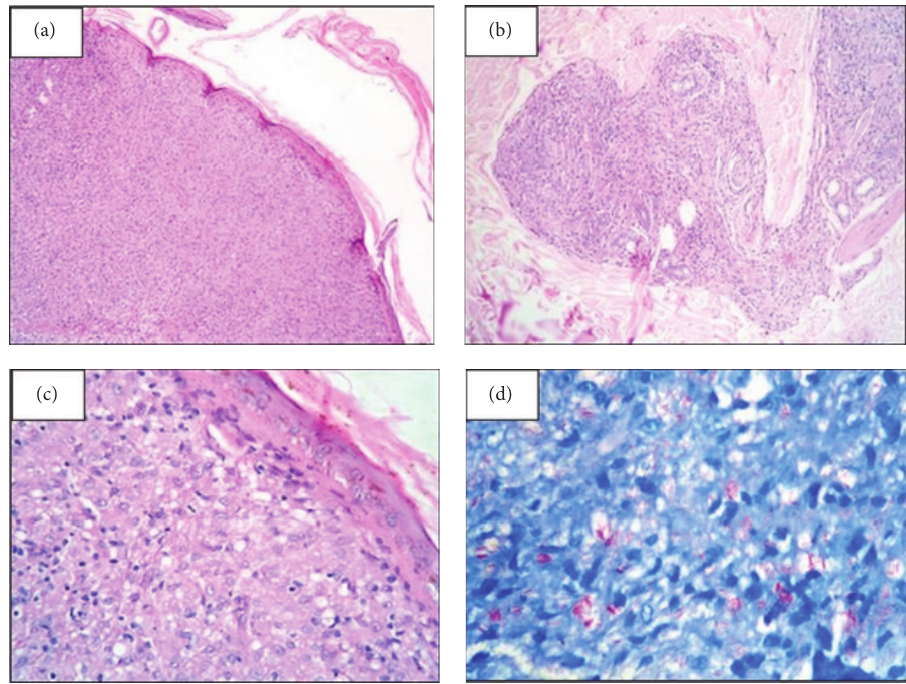
Figure 2: (a) and (b) Wedge biopsy done from the forearm and back nodules shows sheets of histiocytes aggregates along with lymphocytes in perivascular and periadnexal location (H&E, 40x and 100x). (c) Collection of epithelioid cells seen in the dermis (H&E, 400x). (d) Strong positivity for acid fast bacilli (Fite Faraco stain,